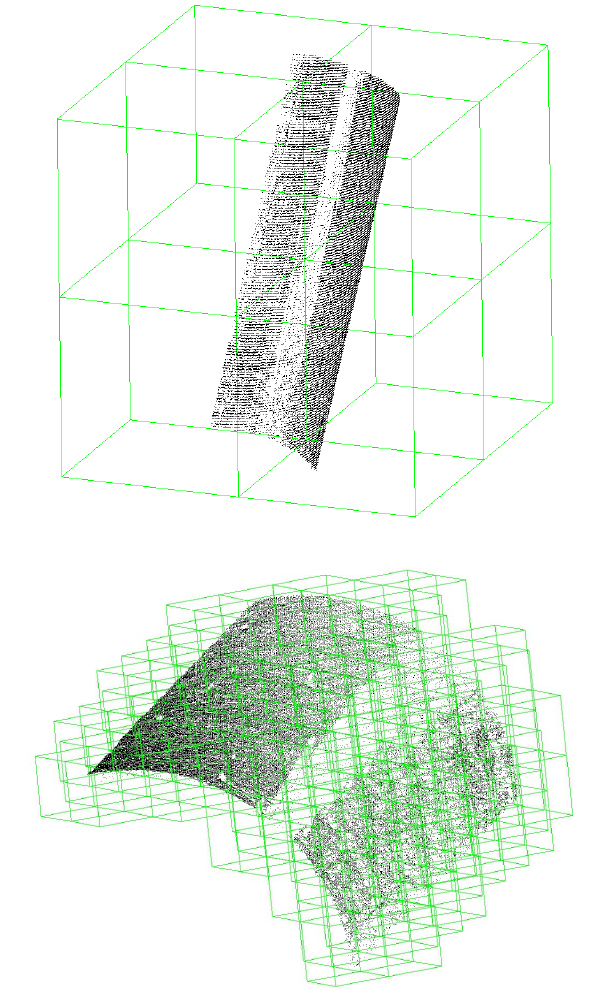
Figure 2: One-level subdivision octree (top) and four-level sub- division (bottom) representation of a portion of the tunnel canal’s vault.